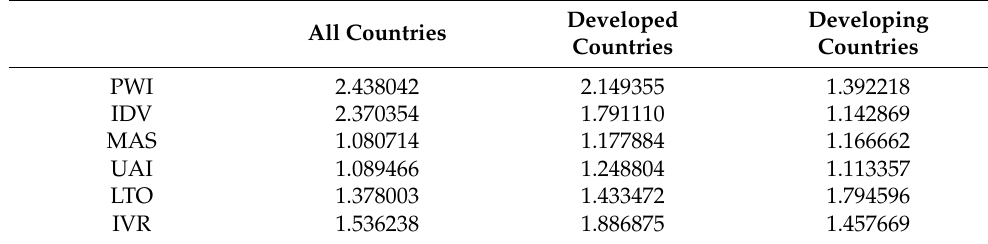
Table A1. A variance inflation factor (VIF) test. All Countries